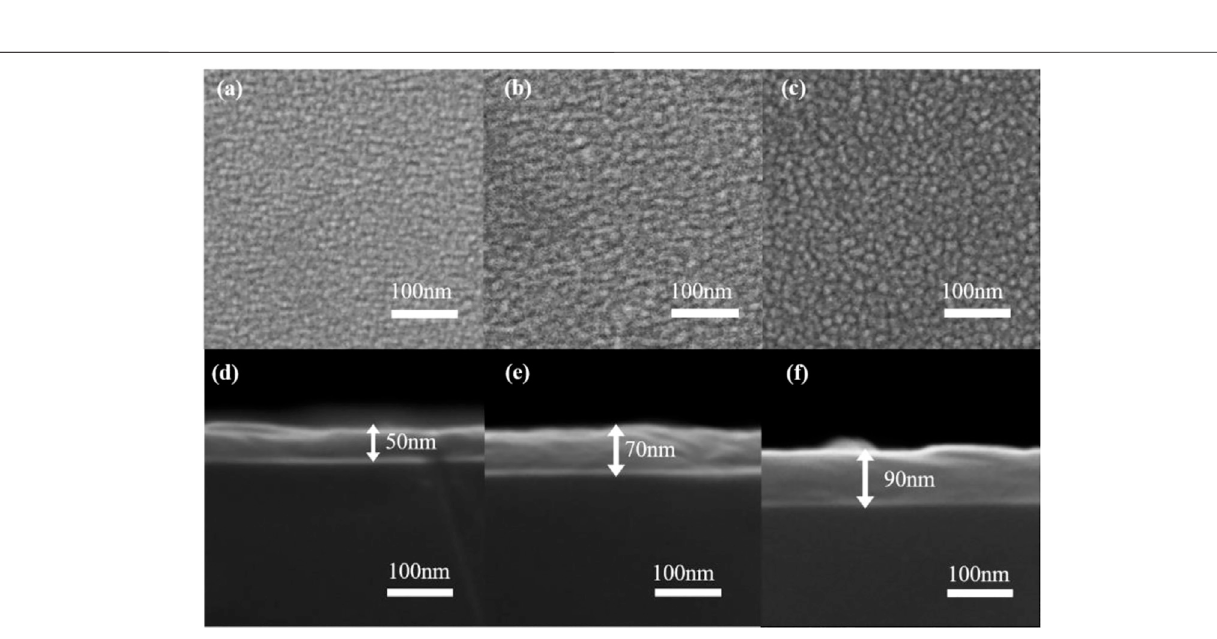
FIGURE 3 | (A) The morphology of the Ag thin fi lm under 5 (A) , 10 (B) , and 15 W (C) DC magnetron sputtering power. (D) The thickness of the Ag thin fi lm under 5 (D) , 10 (E) , and 15 W (F) DC magnetron sputtering